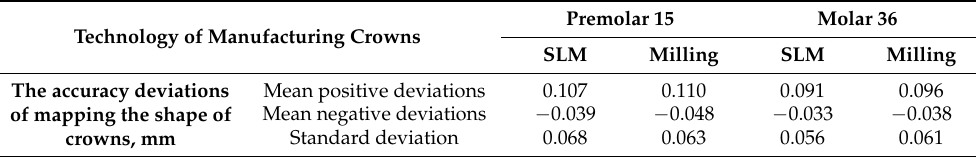
Table 1. List of average deviations in the crown fit for premolars and molars in relation to clinically developed